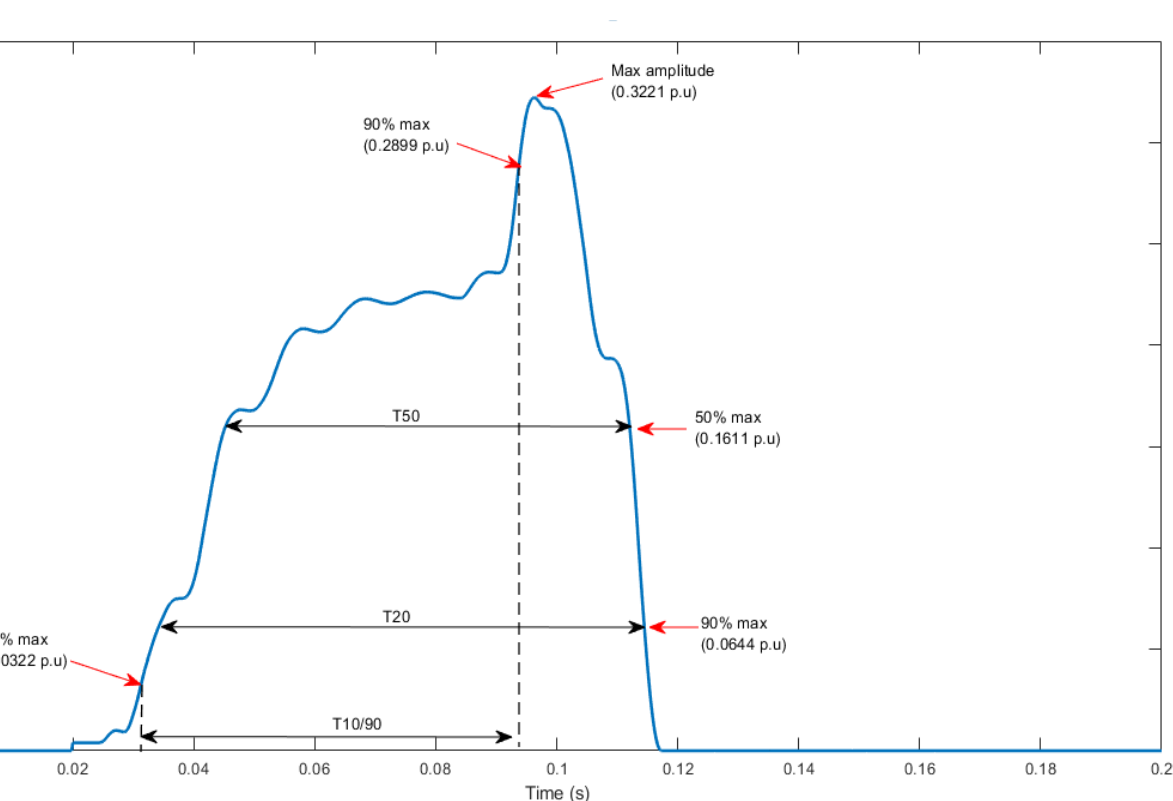
Figure 7. Fault current criteria.